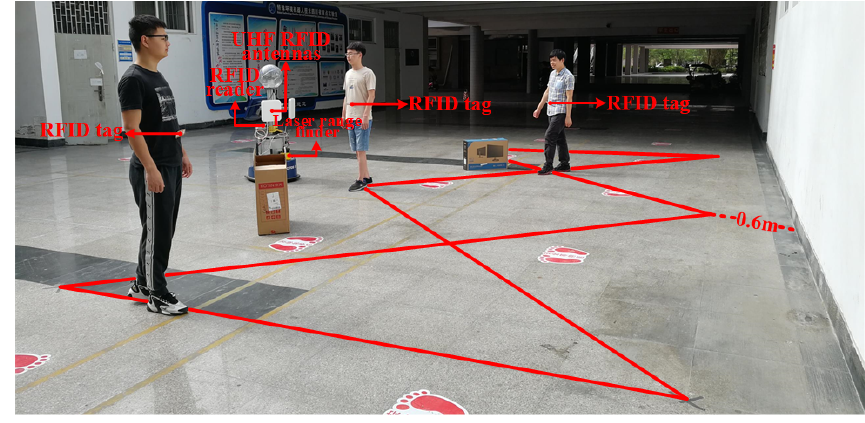
Figure 6. Complex paths experimental